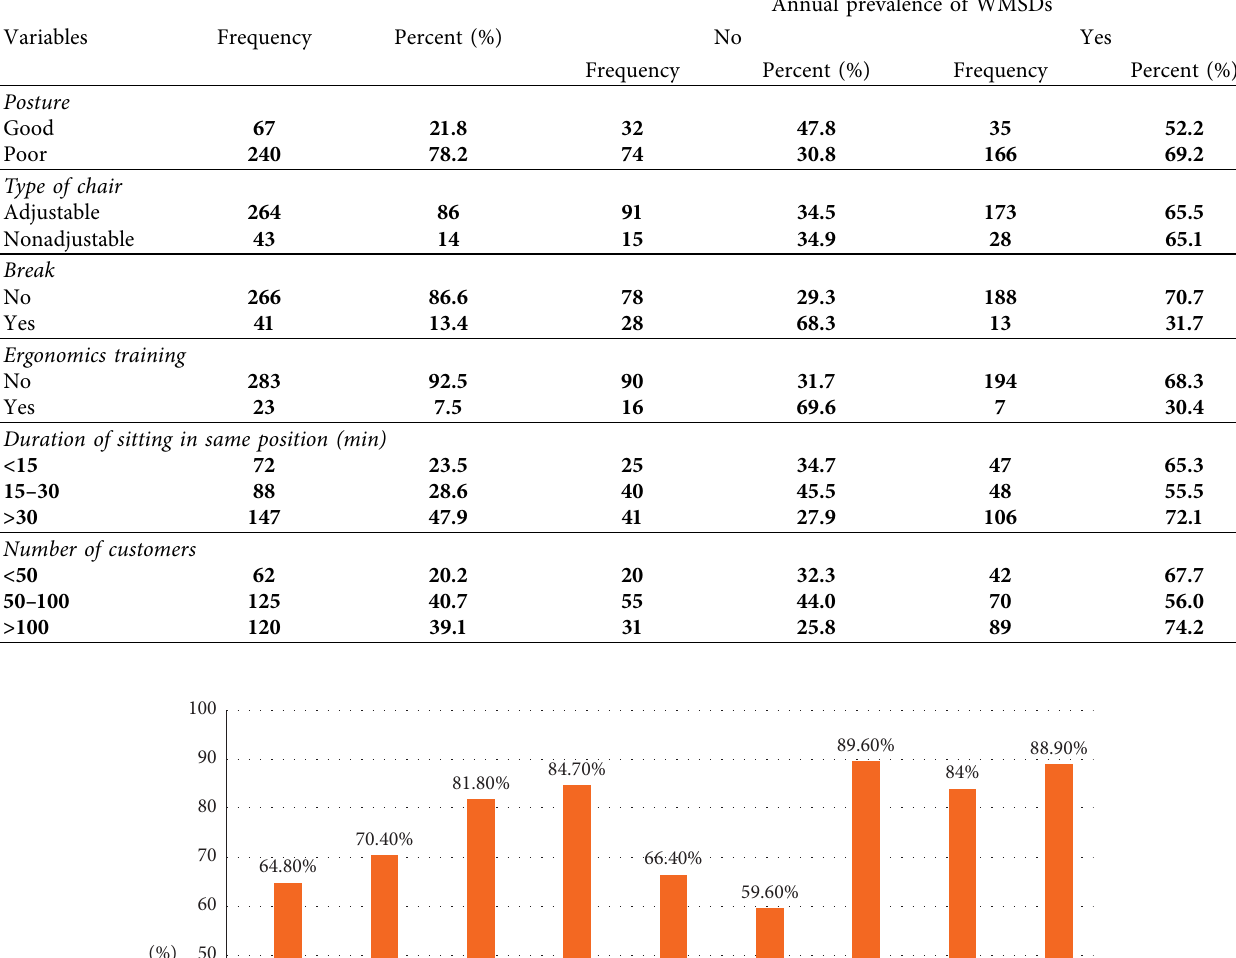
Table 3: Ergonomics and working environment characteristics of bankers working in Mekelle city, Tigray, Ethiopia, May 2018 ( n � 307).